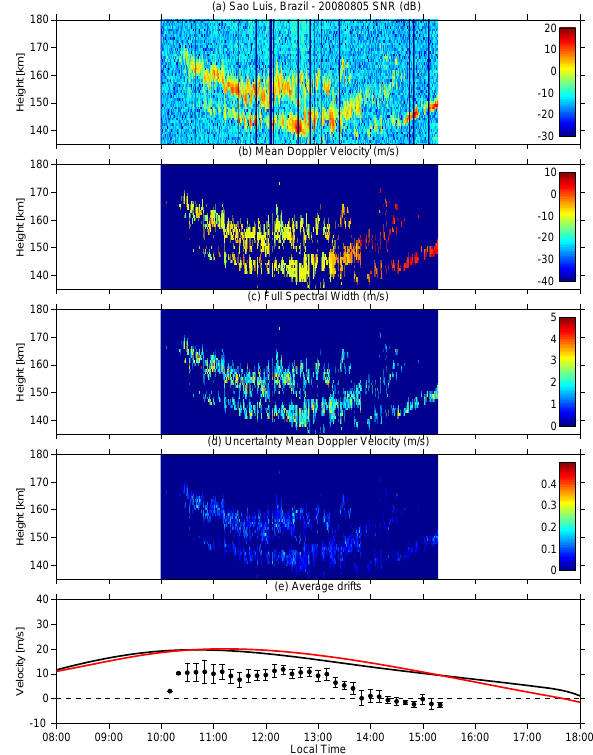
Fig. 4. Same as Fig. 2 but for 5 August 2008. The 3h Kp indices for this day are 0 + , 0 + , 1 − , 1, 1 − , 0 + , 0 + , 0. Fig.4. Same as Figure 2 butfor August 5,2008. The 3-hour Kp indices for this day are: 0+, 0+, 1-,1, 1-, 0+,0+, 0. Our results resemble drift estimates obtained by Patra et al. (2012) using Gadanki radar (13.5 ◦ N, 79.2 ◦ E, 6.5 ◦ N